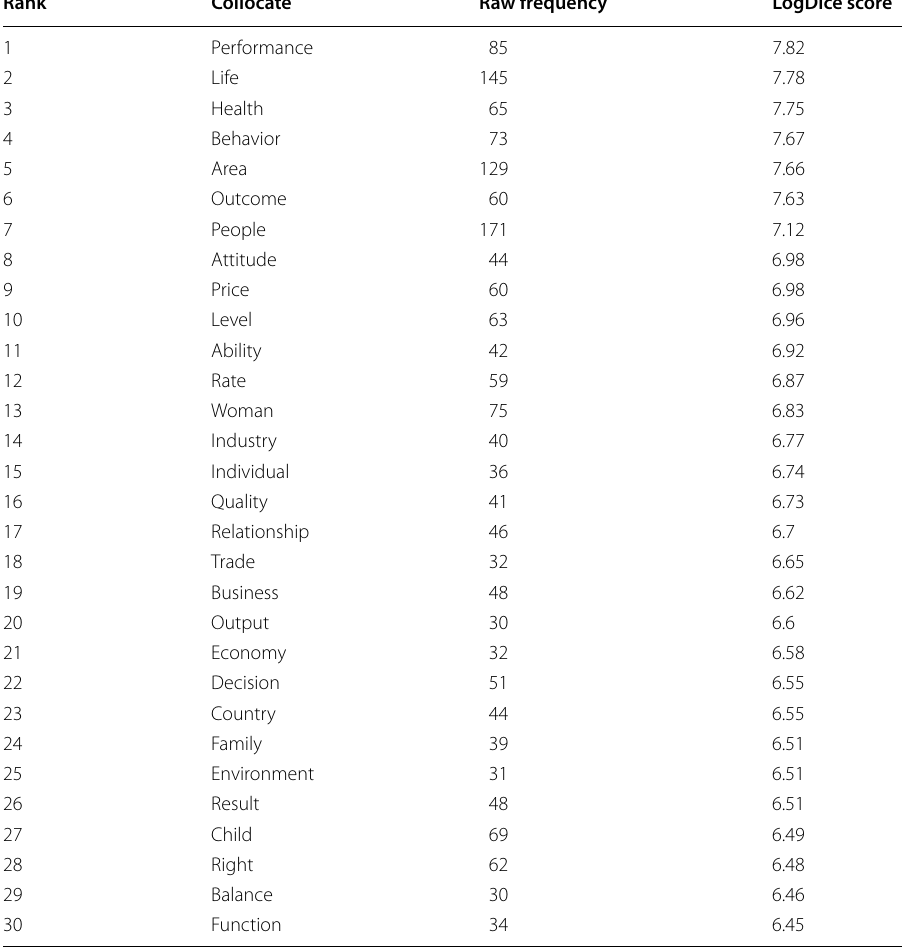
Table 10 Nominal object collocates of affect (Verb) Rank